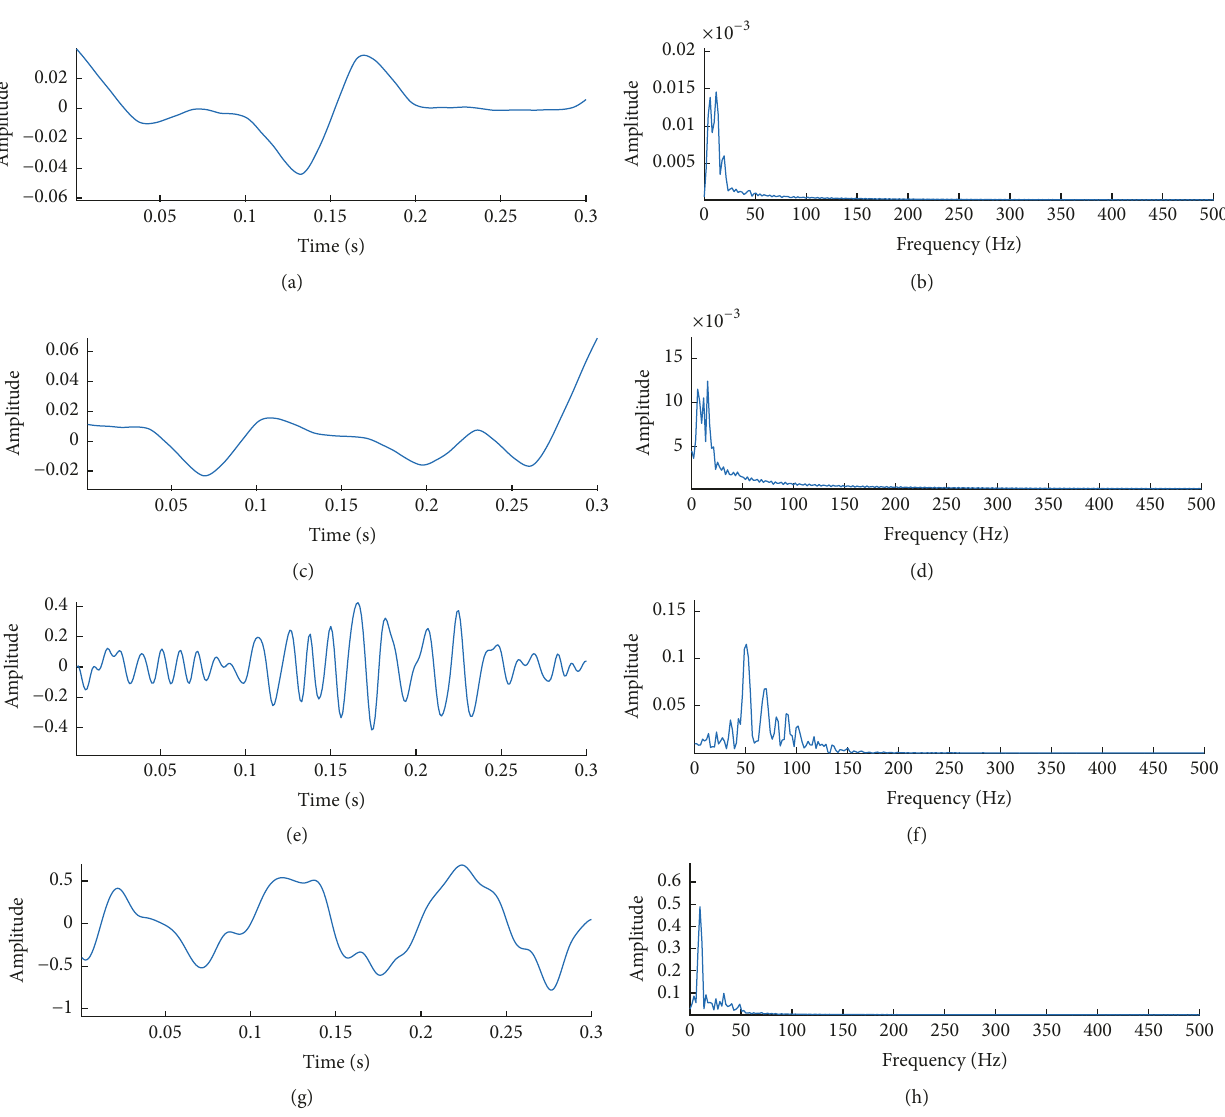
Figure 6: The IMF and spectrum with the vibration signal after the decomposition with ICEEMD-De: (a, c, e, and g) is IMF1 ∼ IMF4 and (b, d, f, and h) is IMF1 ∼ IMF4 spectrum.